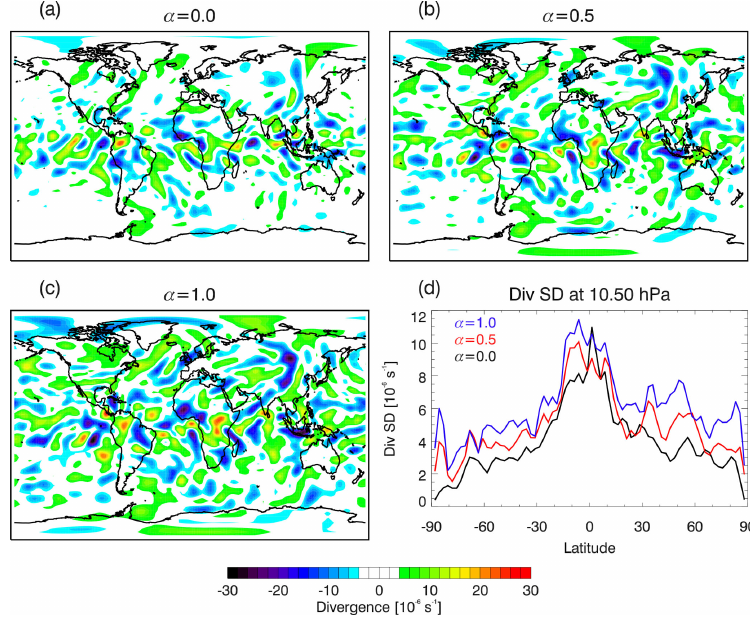
Figure 16. Horizontal maps at 10.5hPa of the divergence (s − 1 ) on 1 December 2014 (00:00Z) for ozone assimilation experiments with (a) α = 0 . 0, (b) α = 0 . 5, and (c) α = 1 . 0. Colors show divergence with red (blue) indicating high (low) values. Panel (d) shows the standard deviation (SD) of the divergence as a function of latitude at 10.5hPa for 1 December 2014 (00:00Z). Lines are α = 0 . 0 (black), α = 0 . 5 (red), and α = 1 . 0 (blue). See Table 1, Sect. 4.2.